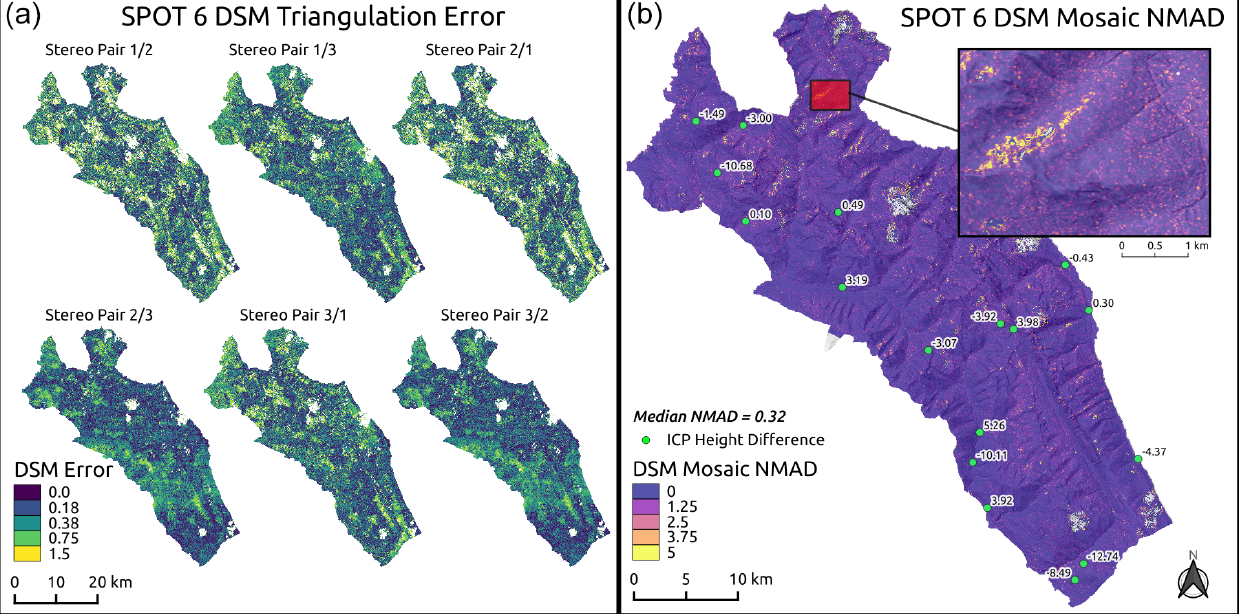
Figure 3. SPOT 6 DSM error estimates. Triangulation error for each set of stereo pairs (a) with pixels where error is greater than im- age resolution (1.5m) removed from DSM. Normalized median absolute deviation (NMAD) for mosaic of six stereo pairs (b) with inset map showing slope-scale detail. Internal checkpoints (green points) with height difference in meters between DSM surface and DGNSS measurement (negative values indicate that the DSM surface height is lower than internal checkpoint, ICP,